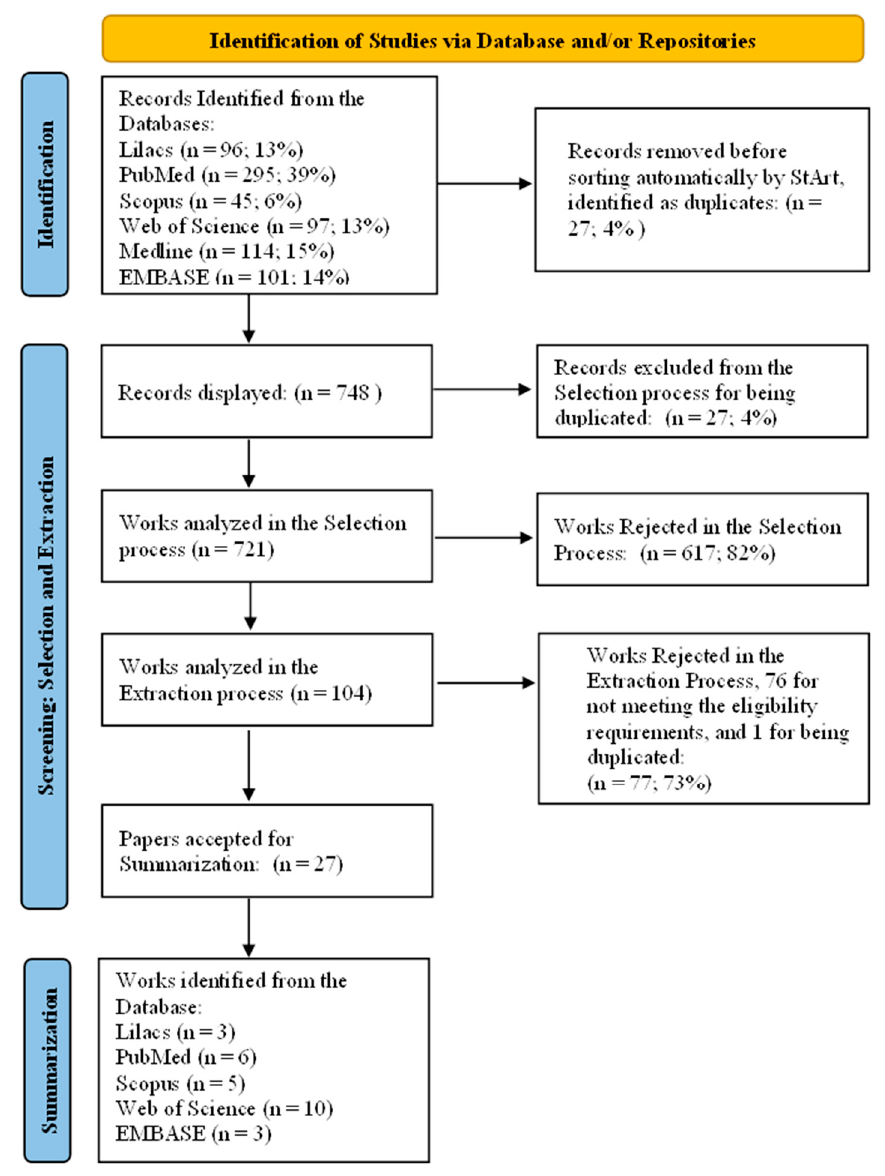
Figure 1. Systematic review diagram. Source: Prepared by the authors, adapted from the diagram proposed by Boers and Mayo-Wilson [39,40].